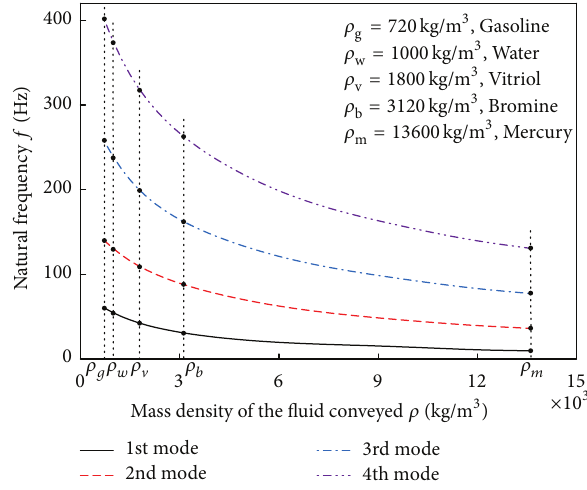
Figure 5: The lowest four natural frequencies of the FGM curved pipes conveying fluid as functions of fluid density for 𝑈 = 120 m/s and 𝑘 = 1 .